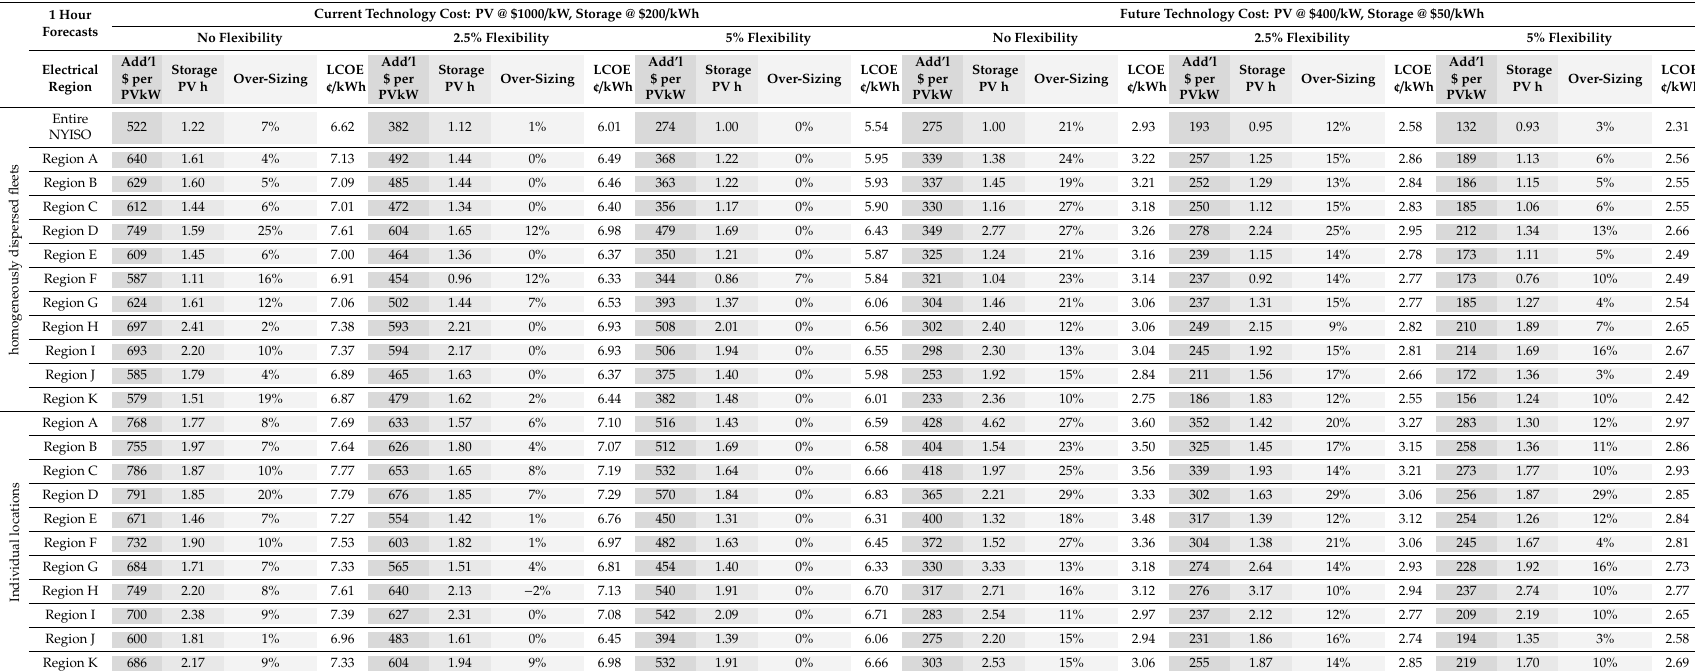
Table A3. One-hour-ahead firm forecast results applying